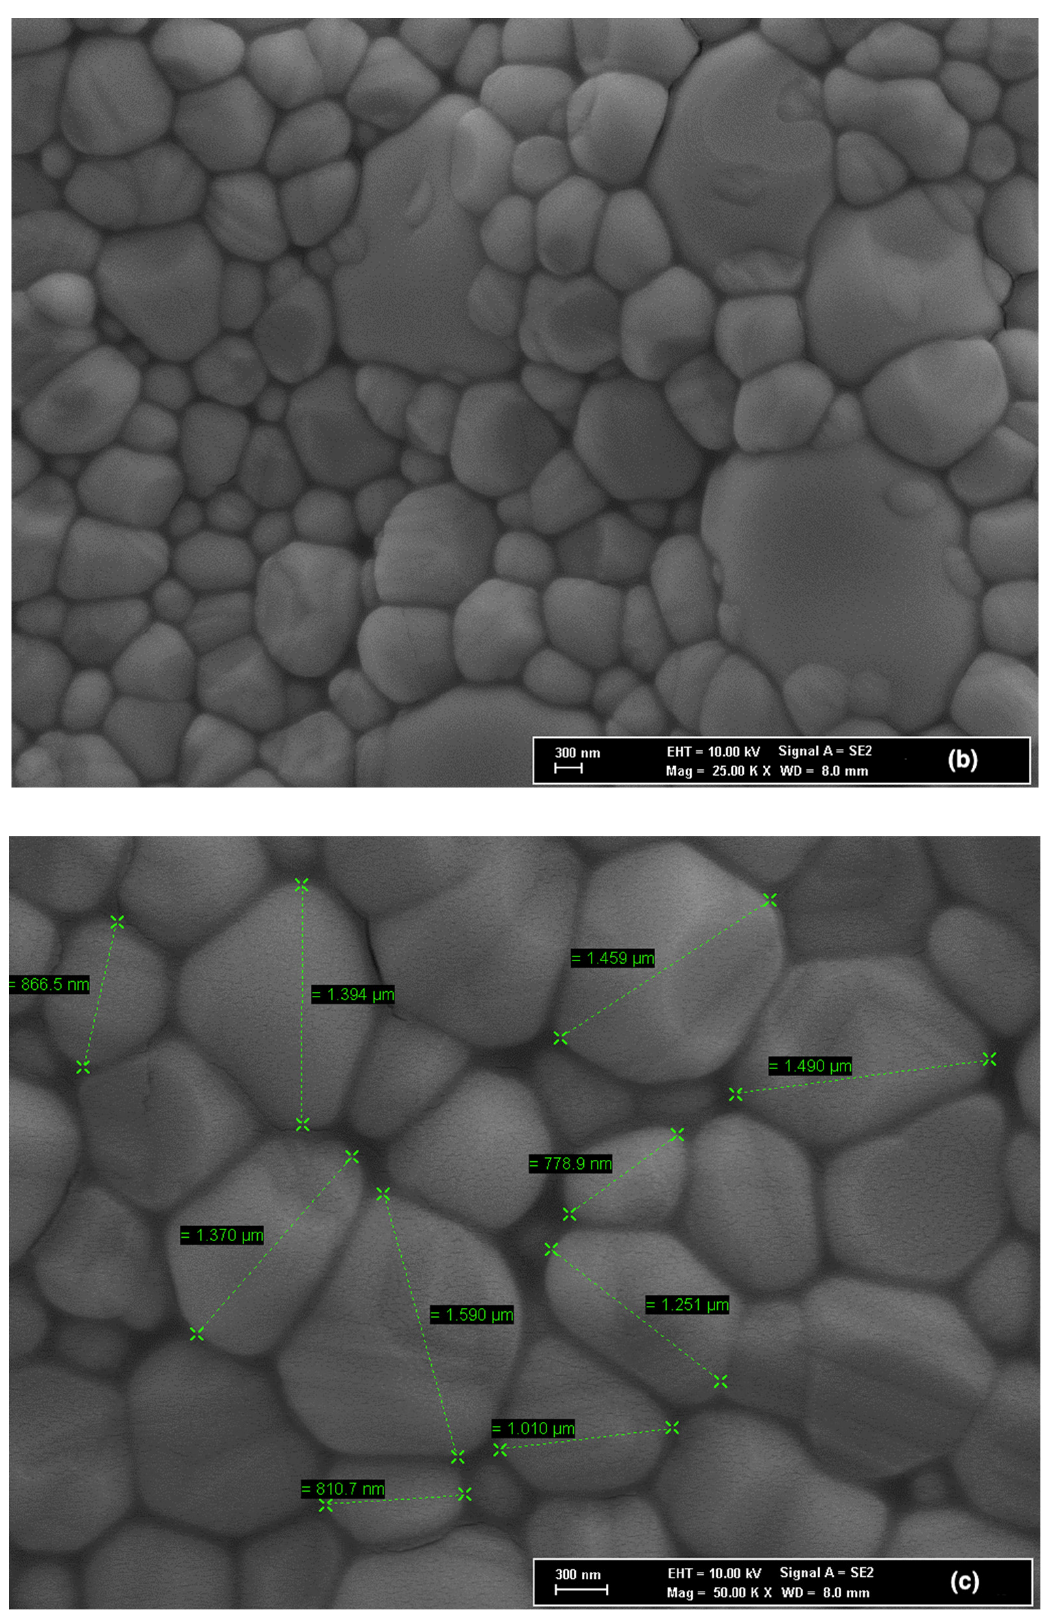
Figure 5. SEM surface micrographs of GDZ-8 electrolyte sample at ( a ) 5 KX, ( b ) 25 KX and ( c ) 50 KX magnification.